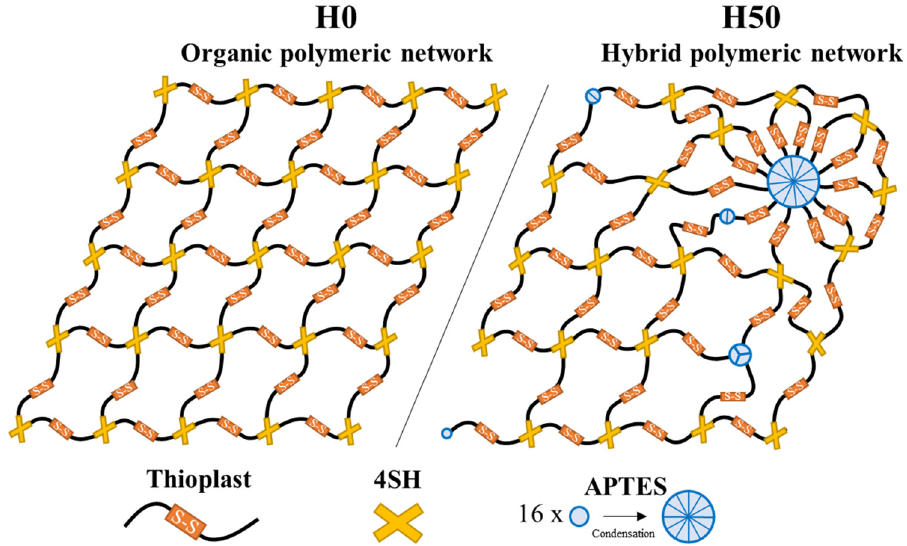
Figure 17. Schematic representation of polymer networks for H0 and H50 materials.